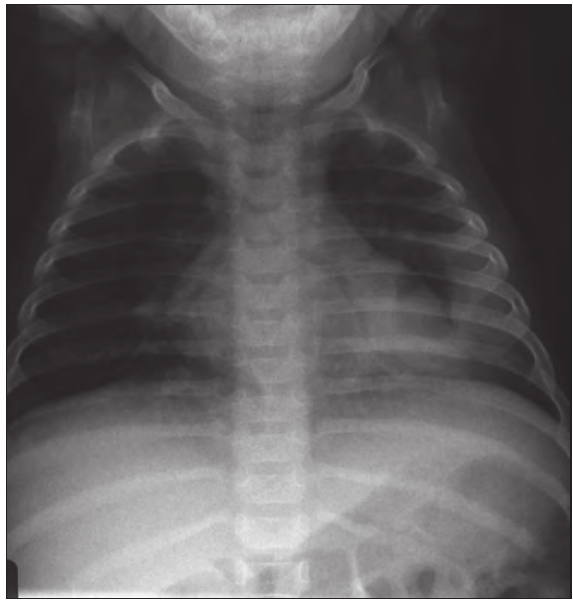
Fig. 2. Anteroposterior chest radiograph at 7 months of